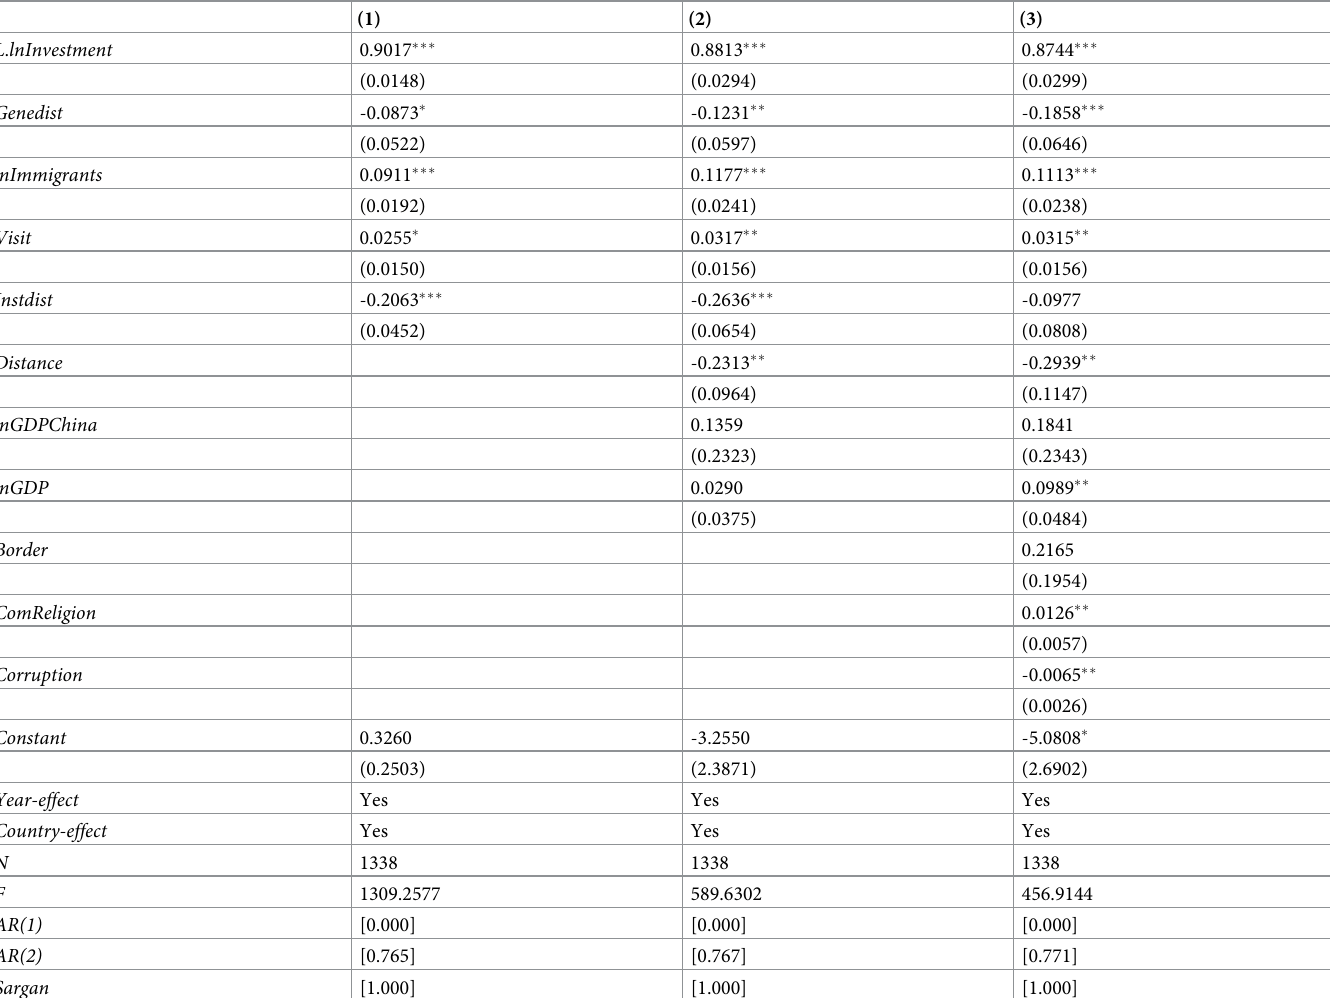
Table 6. The impact of “intimate” relations on China’s OFDI in energy sector: Considering the endogeneity